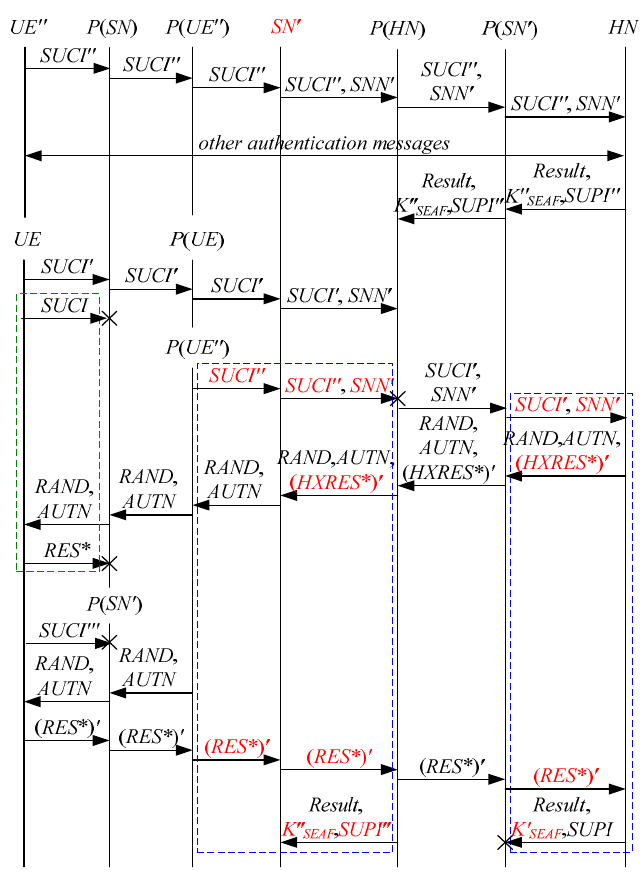
Figure 2. The first attack scenario of the 5G AKA protocol.